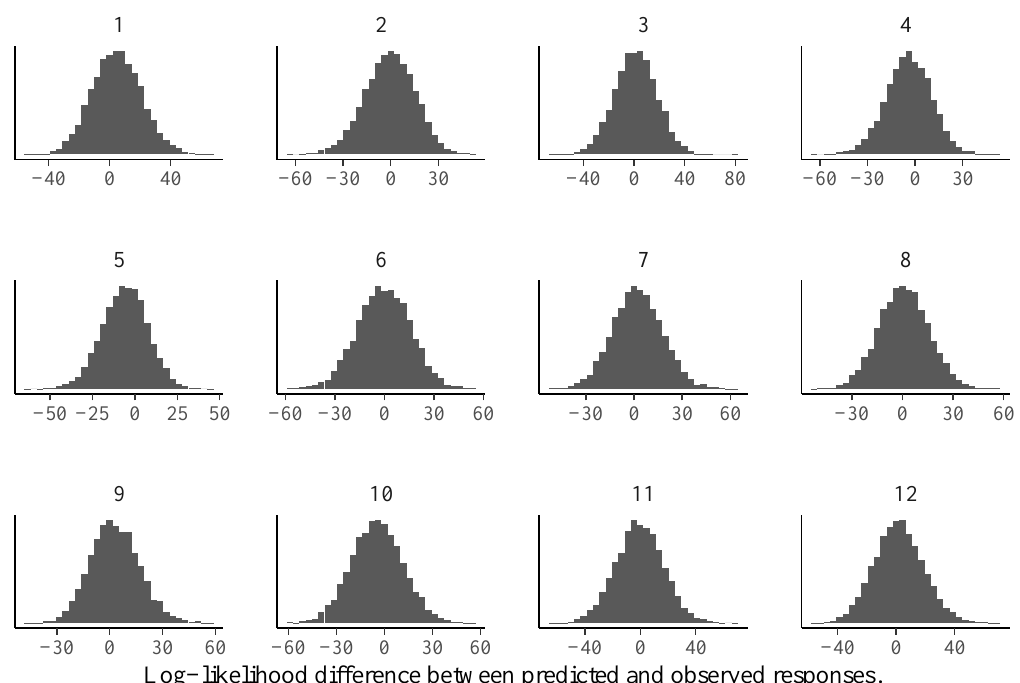
Figure 7. Item-specific posterior distributions of log-likelihood differences between predicted and observed responses for the 3PL model estimated via MCMC-H. If the majority of the posterior distribution is above zero, this indicates model misfit for the given item.